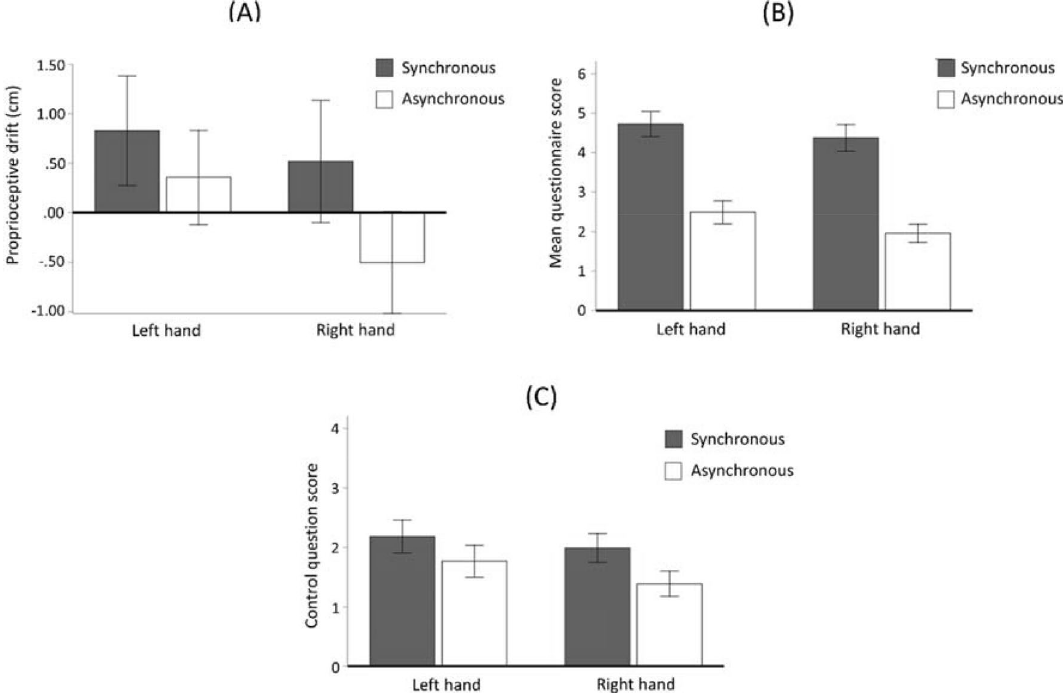
Figure 1. Descriptive statistics of proprioceptive drift ( A ), mean questionnaire scores ( B ) and the control question score ( C ) in the four experimental conditions. Error bars represent ± 1 standard